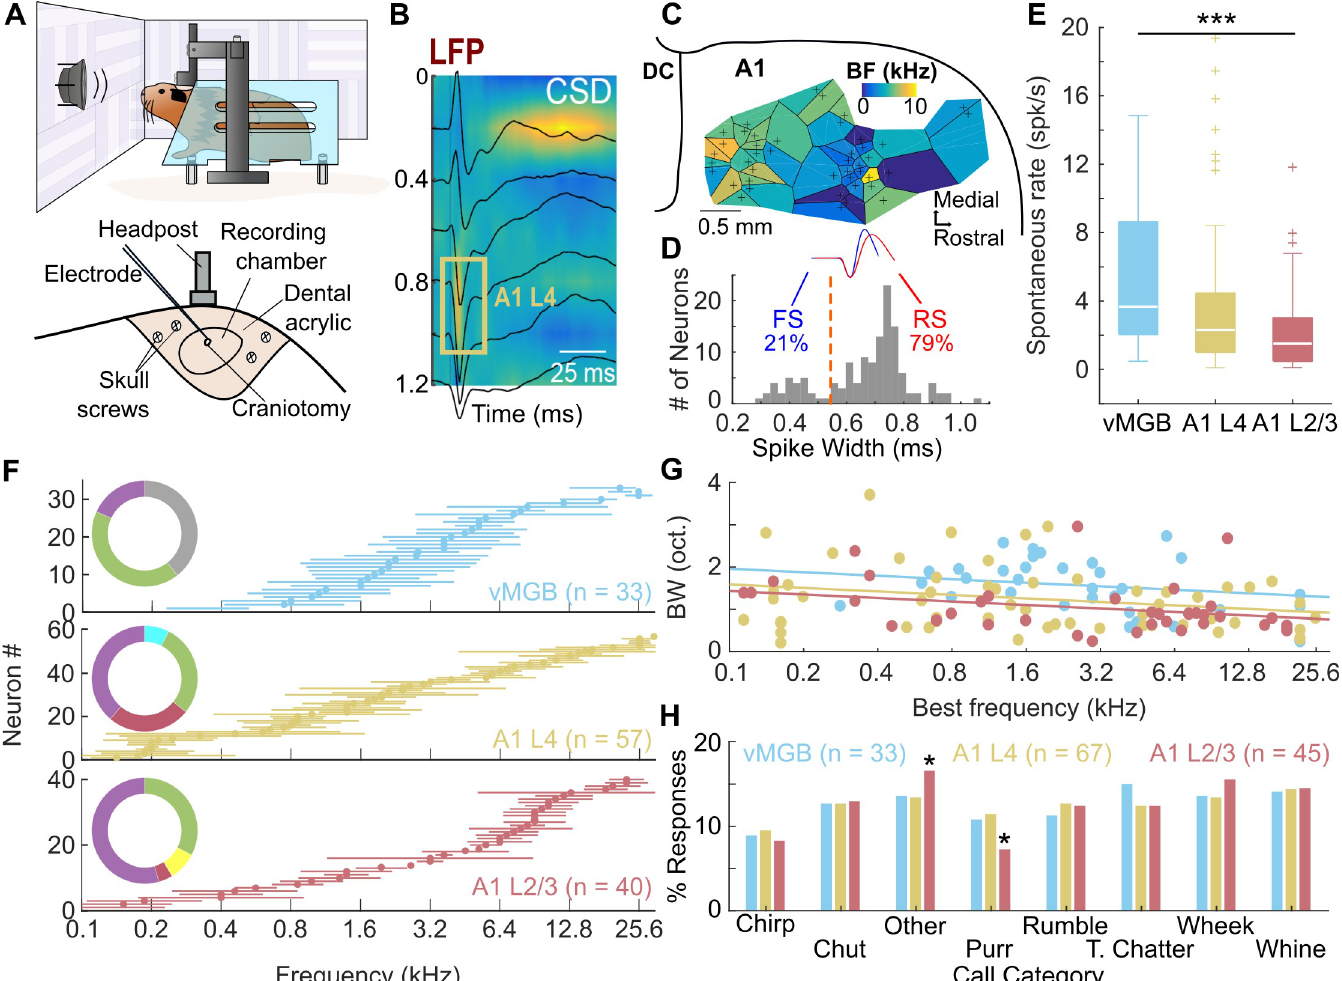
Fig 1. Single-unit recordings from unanesthetized, head-fixed GPs. (A) Recording setup (top) and details of cranial implant (bottom). (B) Average LFP traces (black lines) and CSD (colormap; warm colors correspond to sinks) of an example electrode track in A1. Yellow box outlines estimated A1 L4 location. (C) Example Voronoi map showing tonotopy of auditory cortex in one GP. Colormap corresponds to best frequency. (D) Histogram of spike widths of sorted single units. Dashed orange line is the threshold used to separate FS (blue) from RS (red) units. (E) Distribution of spontaneous rates in vMGB (blue), A1 L4 (yellow), and A1 L2/3 (red). ��� p < 0.005, Kruskal–Wallis test (Dunn–Sidak post hoc test). (F) Best frequencies (discs) and bandwidths (lines) of tone-responsive neurons recorded from vMGB, A1 L4, and A1 L2/ 3 (colors as earlier). Insets show distribution of units across subjects, colors correspond to individual subjects. (G) Tone tuning bandwidth plotted as a function of best frequency across all 3 auditory stages tested. Dots correspond to individual neurons, and lines correspond to linear fits constrained to have the same slope. (H) Fraction of call-responsive neurons in vMGB, A1 L4, and A1 L2/3 that respond to each call category ( � p < 0.05, two-sided permutation test with FDR correction). Data underlying this figure can be found in Supporting information file S1 Data. CSD AU : AbbreviationlistshavebeencompiledforthoseusedinFigs 1 (cid:0) 9 : Pleaseverifythatallentriesarecorrect : , current source density; FDR, false discovery rate; FS, fast-spiking; GP, guinea pig; LFP, local field potential; RS, regular-spiking.